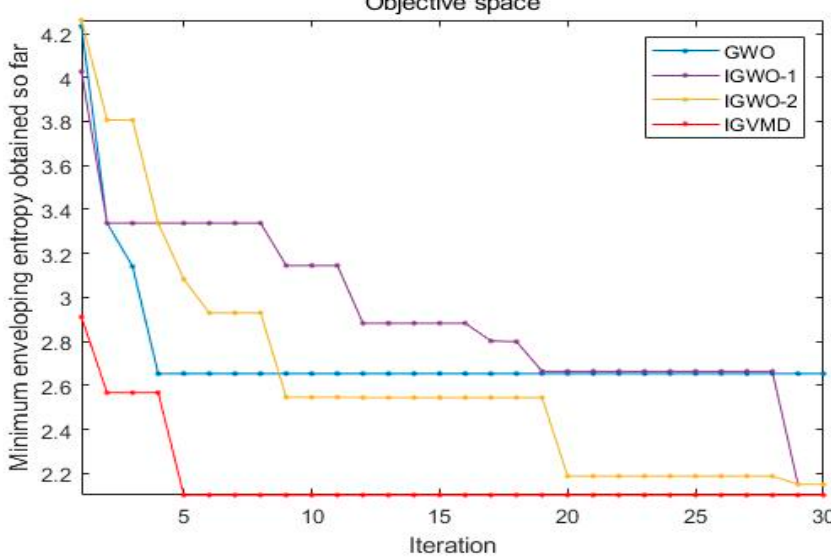
Figure 9. Fitness value curves for each algorithm.